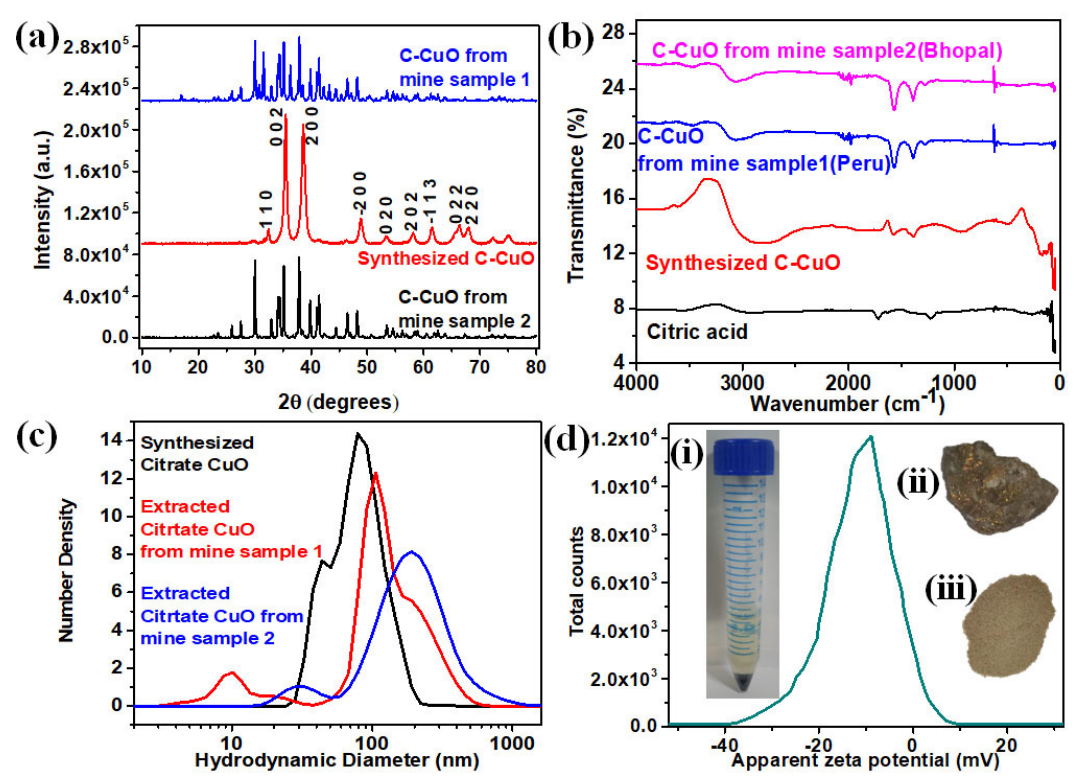
Figure 1. ( a ) XRD of the synthesized and extracted (from Peru and Bhopal samples) CuO nanoparticles. ( b ) FTIR spectra of different citrate-capped CuO samples and citric acid in the range between 0 and 4000 cm − 1 , ( c ) DLS of the citrate-capped CuO from supernatants of C-CuO samples, ( d ) zeta potential distribution of the synthesized citrate functionalized CuO NP. The insets (i), (ii), and (iii)